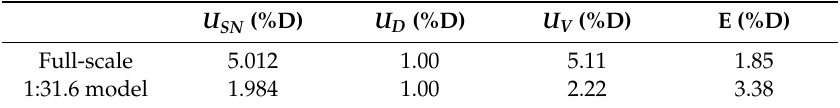
Table 13. Validation study.